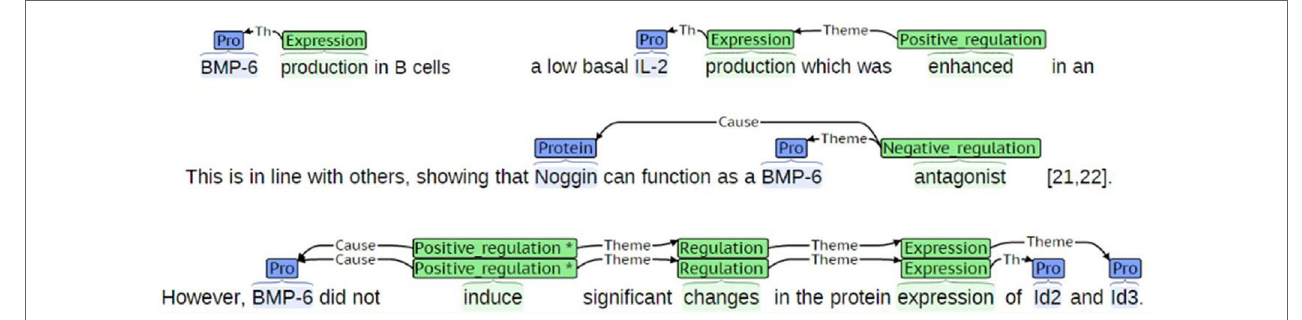
FigUre 5 | An example of event detection in a sentence.